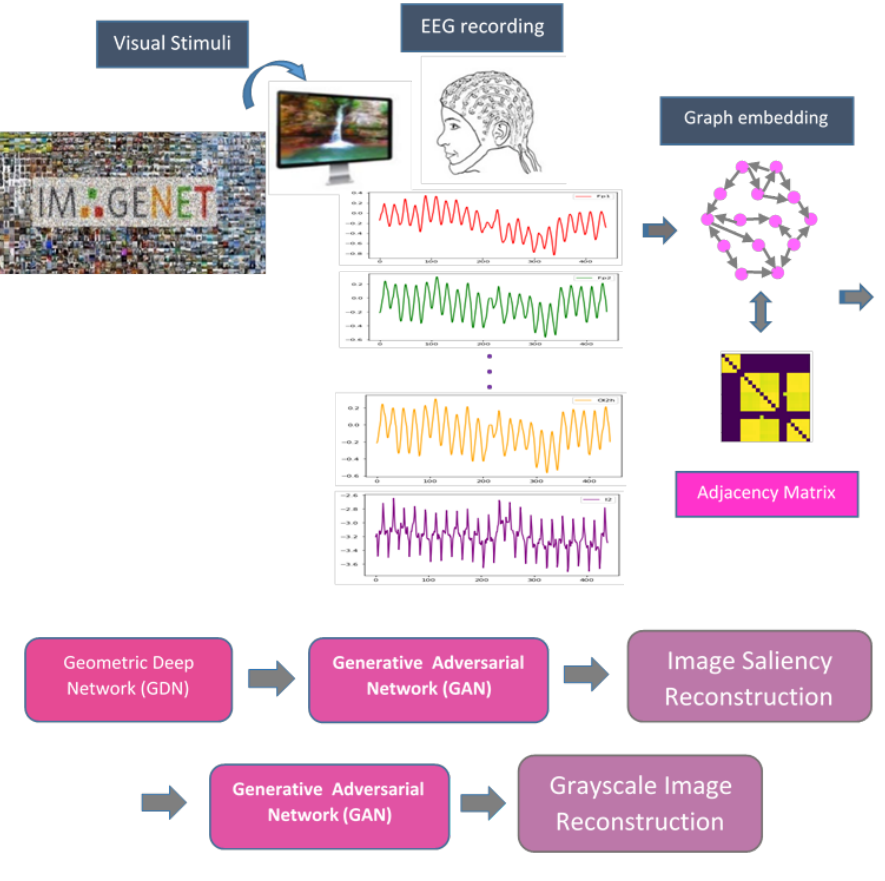
Figure 2. The schematic overview of the proposed